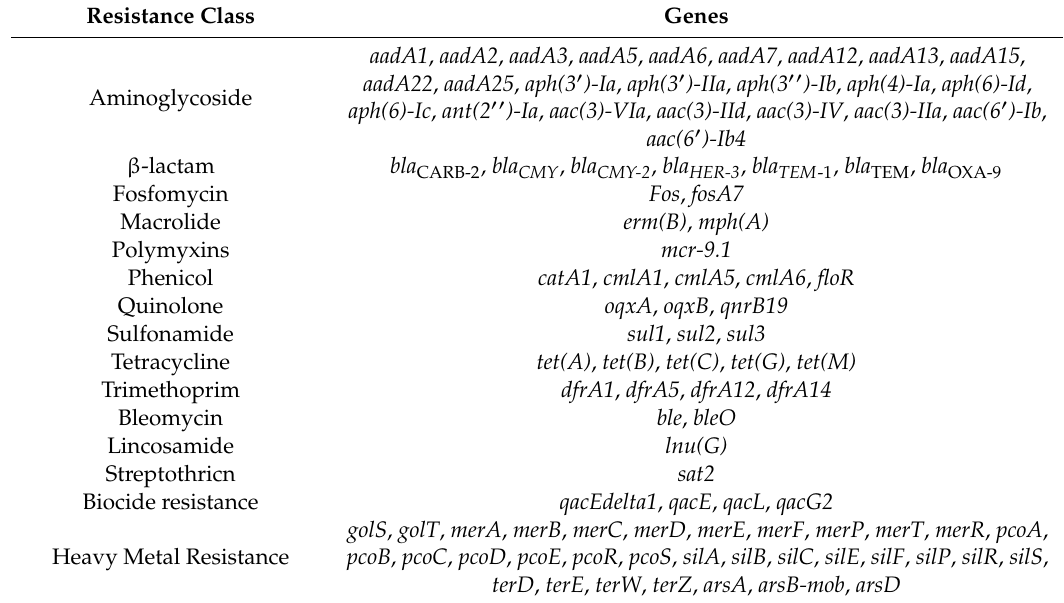
Table 2. Identified antimicrobial, biocide, and heavy metal resistance genes from 450 Salmonella strains.